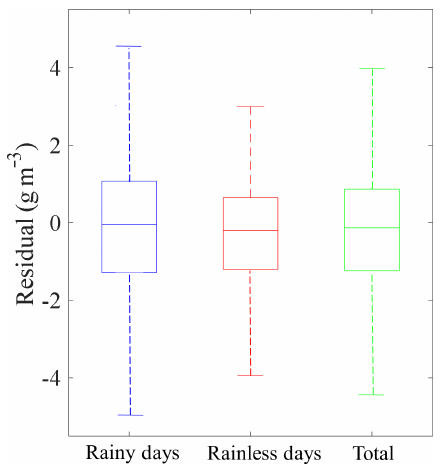
Figure 11. Box plots of the WVD residuals, which are computed between the GA tomographic approach and radiosondes.